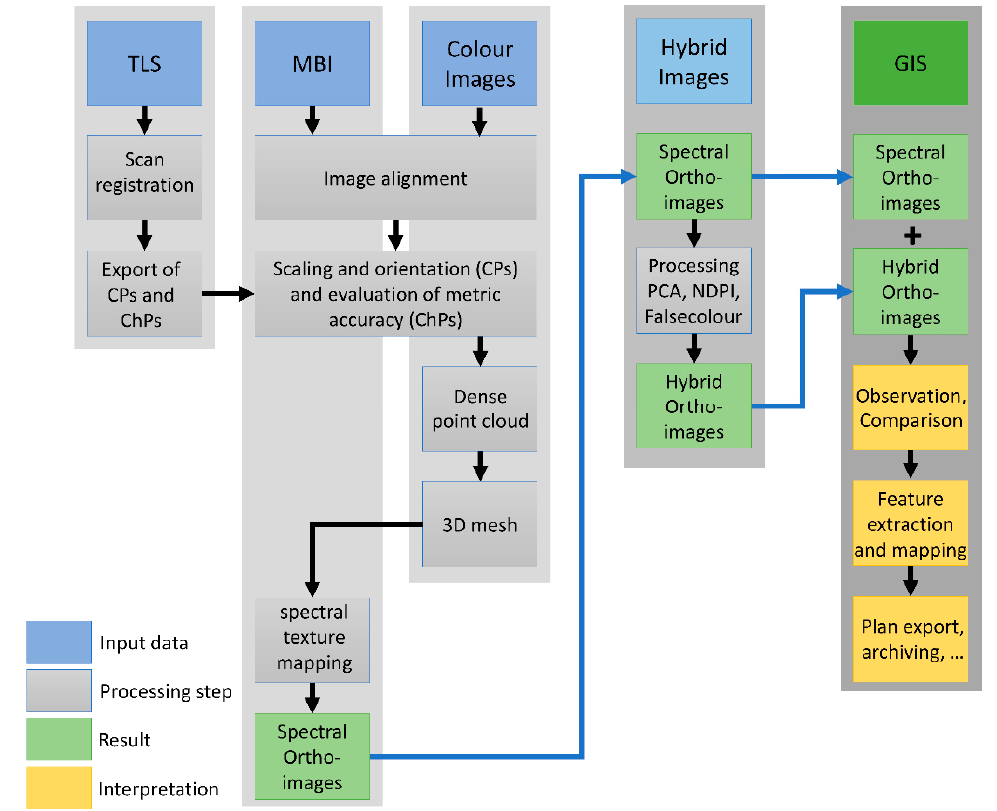
Figure 3. Schematic overview of the workflow for data processing and data fusion.